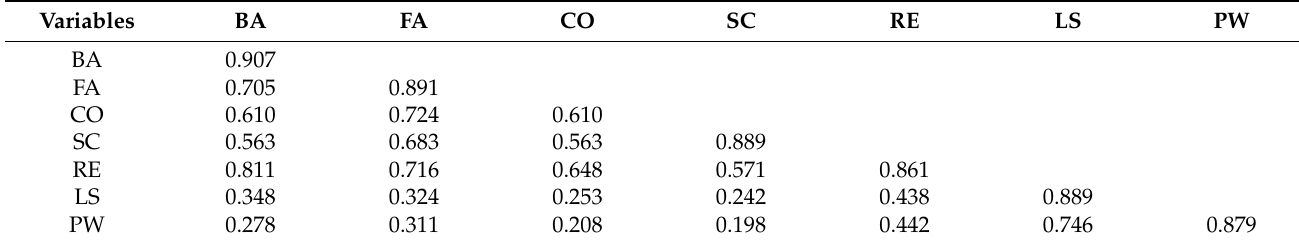
Table 4. The discriminant validity of constructs.